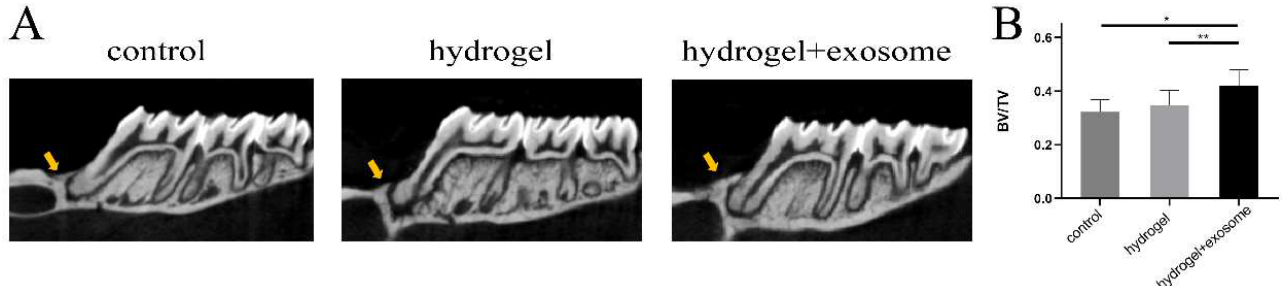
Figure 4. LSCM images of ( A ) hydrogel (control) and ( B ) hydrogel with red fluorescence DiD-la- beled exosomes (hydrogel + exosome).